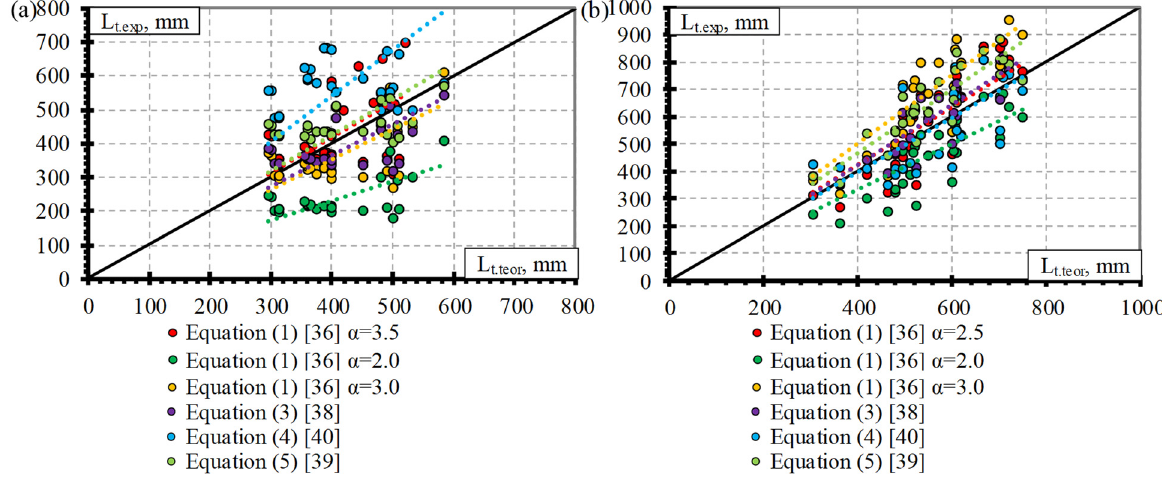
Figure 8. Comparison of experimental and theoretical transfer length results of ( a ) CFCC strands and ( b ) CFRP bars. ( b ) CFRP